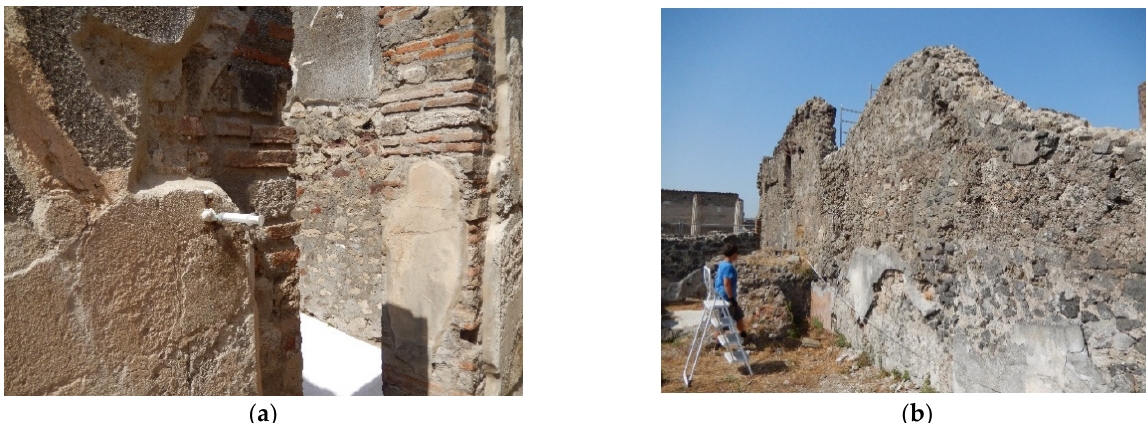
Figure 6. The masonry walls in the Championnet area. ( a ) A sample of the variety of masonry walls. ( b ) A long structural masonry wall before rehabilitation, with evidence of the alveolation and damage.